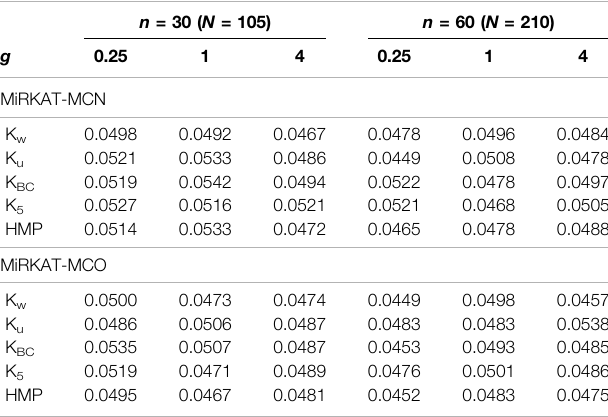
TABLE 2 | Empirical type I errors of MiRKAT-MC for clustered data with a random intercept and a random slope model with three-category